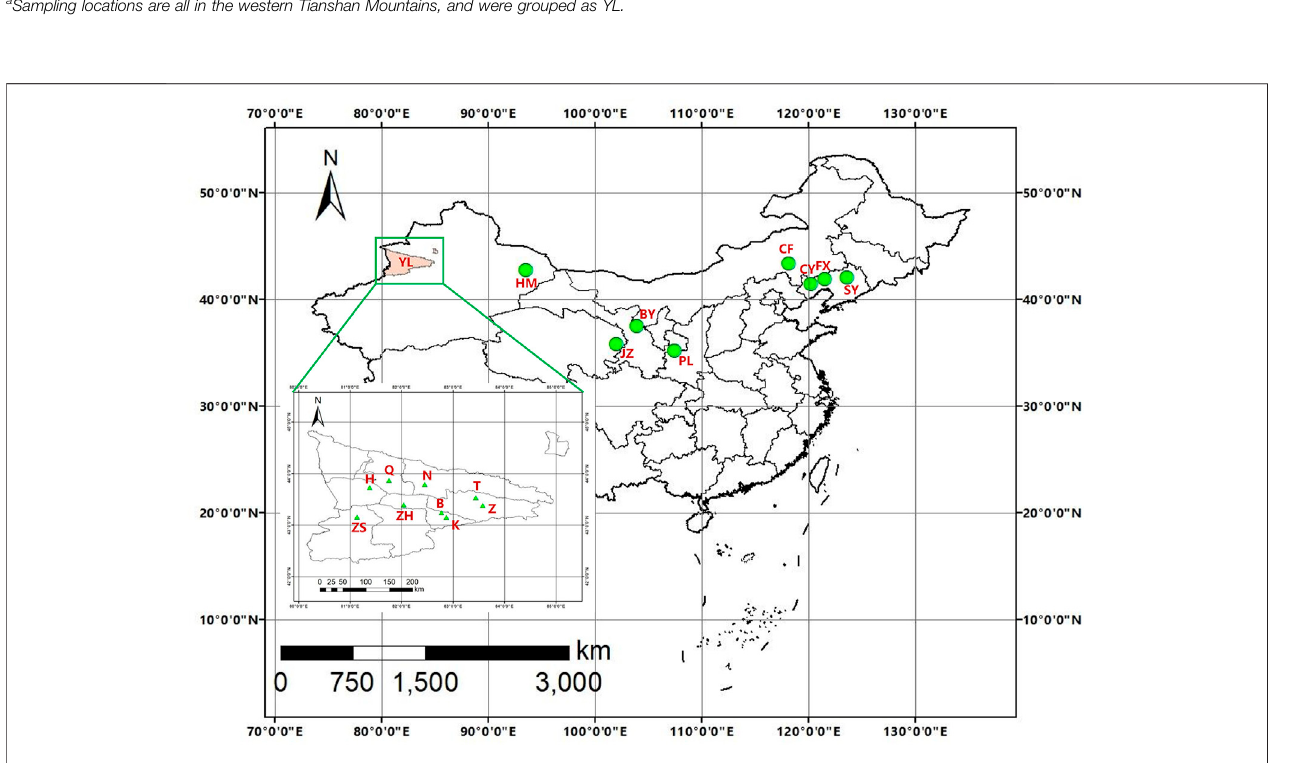
FIGURE 1 | Geographical distribution of 17 sampling populations of A. mali